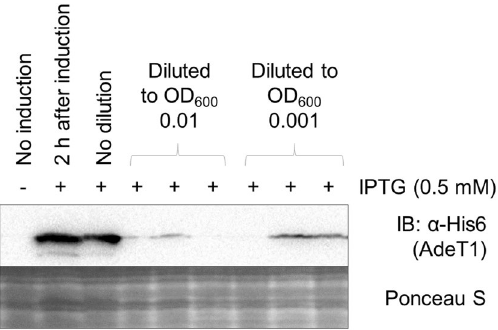
Figure 4. AdeT1 production was not always detectable after dilution of the induced culture to low optical density and subsequent overnight incubation in the presence of IPTG. E. coli KAM32 carrying pAdeT1*-His6 were induced with 0.5 mM IPTG at OD 600 ~ 0.6. After 2 h, the induced culture was diluted to either OD 600 0.01 or 0.001 in fresh media containing 0.5 mM IPTG and 100 μg/mL ampicillin (for plasmid selection). Three technical replicates were prepared for each dilution. Full blots are shown in Supplementary Fig.